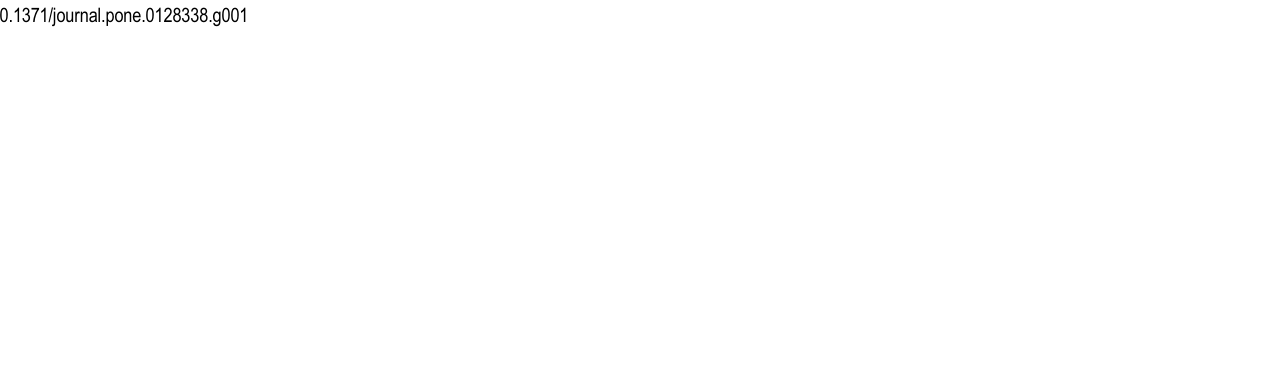
PLOS ONE | DOI:10.1371/journal.pone.0128338 June 17,